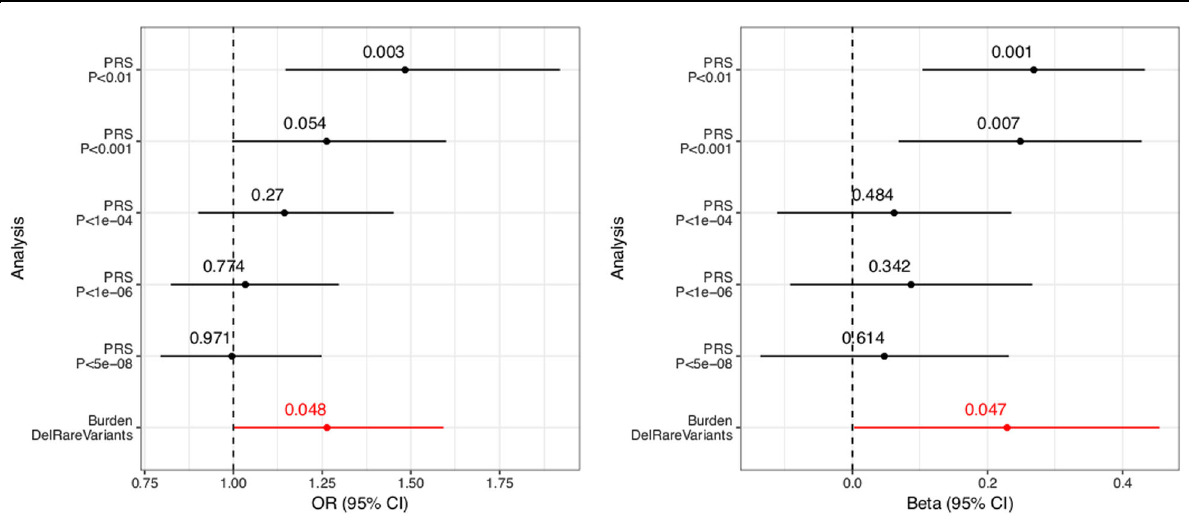
Fig. 2 Forest plot displaying the mean and con fi dence interval of regression coef fi cients of PRS analysis and rare variant burden analysis for SNVs. We compared the quantile-normal transformed PRS estimated from PGC BP1 GWAS summary statistics between BP1 individuals and controls and also compared the burden of rare deleterious SNVs between BP1 individuals and controls in the 8,237 genes relevant to BP. PRS is computed at different GWAS p value thresholds of the PGC BP1 GWAS. The burden score was regressed on the burden of all rare variants in the 8,237 genes, and the residuals were quantile-normal transformed. The black lines indicate results of the PRS analysis while the red line indicates results of the rare variant burden analysis. The association between PRS and BP1 status and between the rare variant burden and BP1 status was assessed using a generalized linear mixed model (left) and a linear mixed model (right) that took into account